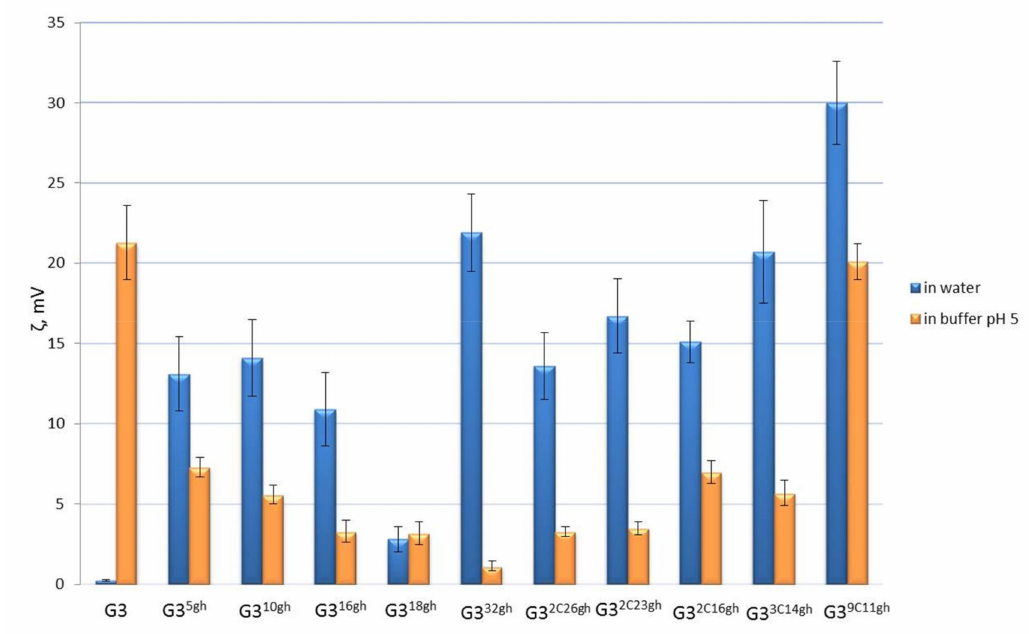
Figure 6. ζ potential values for G3 gh and G3 Cgh conjugates measured for 0.1 mM solutions of conjugate in 0.04 M acetate bu ff er pH 5 (orange columns) and in water (blue